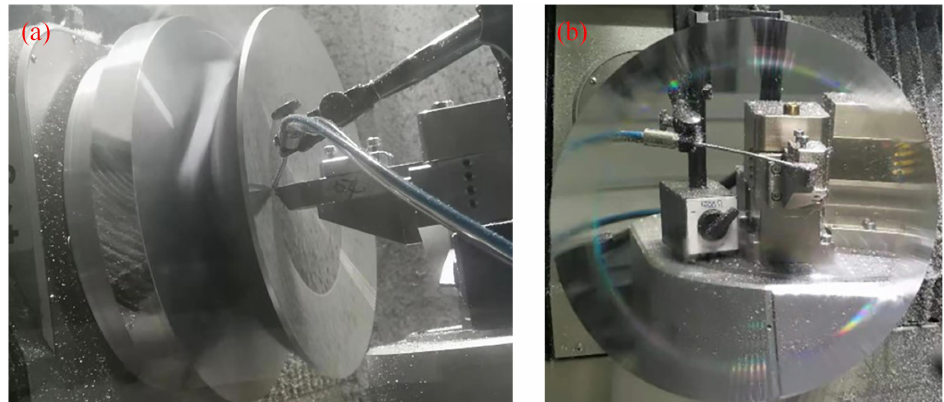
Figure 13. Single-point diamond-turning of optical surface of SLM aluminum alloy mirror. ( a ) Single- point diamond-turning of optical surface. ( b ) Optical processing of SLM aluminum alloy mirror surface processing of SLM aluminum alloy mirror surface.